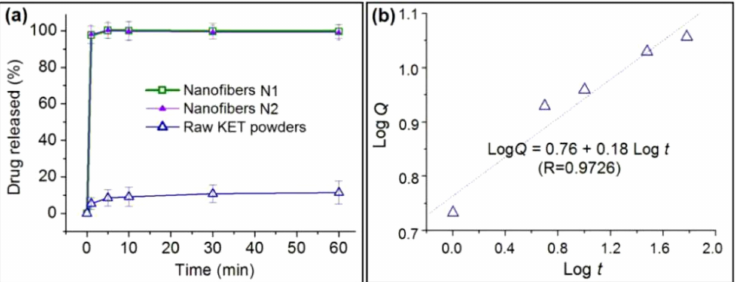
Figure 9. In vitro dissolution profiles of N1, N2, and raw KET powders ( a ), and the drug release mechanism of KET powder ( b